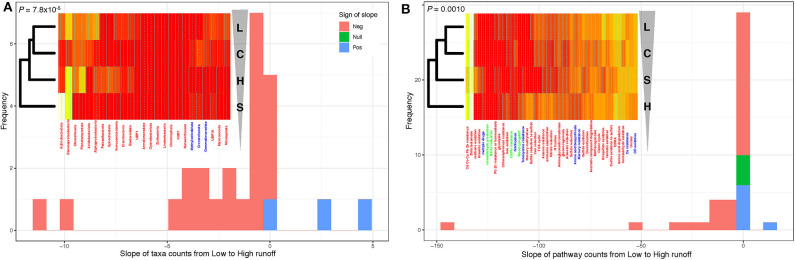
Transition from low to high runoff leads to a decrease in diversity. (A) Distribution of the slopes of taxonomic counts as a function of sites. (B) Distribution of the slopes of pathway counts as a function of sites. In both cases, counts were aggregated by location types (L [Low], C [Control], S [Soil], and H [High] sites), and linear models (ANOVA) were fitted to estimate the slope of each regression. Insets: heatmap representations of count tables (from white [low counts] to red [high]); leftmost dendrograms (hierarchical clustering) show how the location types cluster, transitioning from L to H runoffs (vertical triangle pointing down). Note that these dendrograms are “unrooted,” which means that in both panels, L and C one the one hand and H and S on the other hand cluster together. P-values: one-sided binomial test for enrichment in negative slopes across the 25 phyla. See Supplementary Figure 7 for additional details.